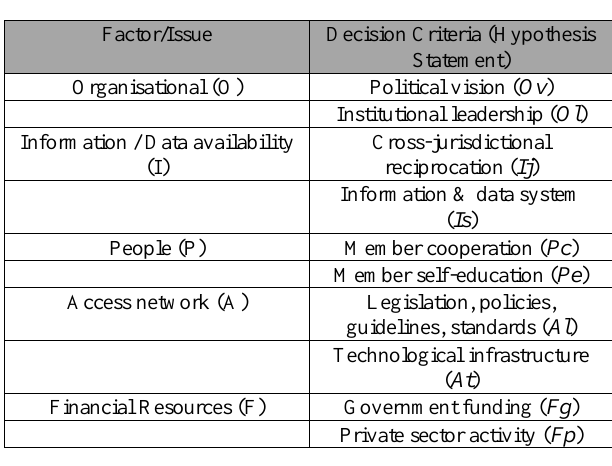
Table 1 . Decomposition of factor/issue categories of SDI readiness into decision criteria Adapted: (Delgado et al.